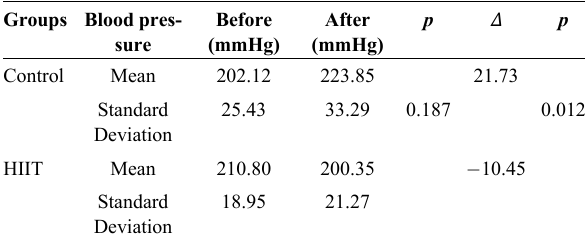
Table 1 - Systolic blood pressure results. Groups Blood pres- sure